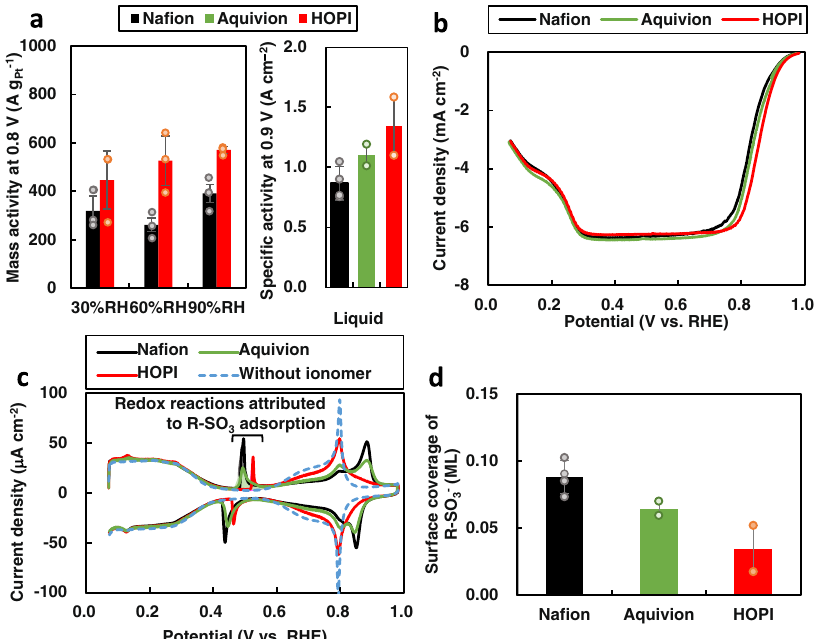
Fig. 6 Electrochemical characterizations of single-crystal electrodes. a Mass ORR activity in the MEAs with the Na fi on ionomer and HOPI (left), and speci fi c activity of the Pt(111) surfaces covered by the Na fi on ionomer, Aquivion ionomer, and HOPI (right). b , c Linear-sweep voltammograms and CVs of the Pt(111) surfaces covered by the Na fi on ionomer, Aquivion ionomer, and HOPI under oxygen-saturated and inert conditions, respectively. d Surface coverage of sulfonate anions in the ionomers determined from the adsorption charges in the CVs. The adsorption charges were determined by subtracting the background charges calculated from the CV in a 0.1 mol dm − 3 HClO 4 solution without an ionomer (blue dashed line in c ). The plots in bar graphs are the measured data, and error bars show their root mean square differences. Bars show their averages based on two to four separate